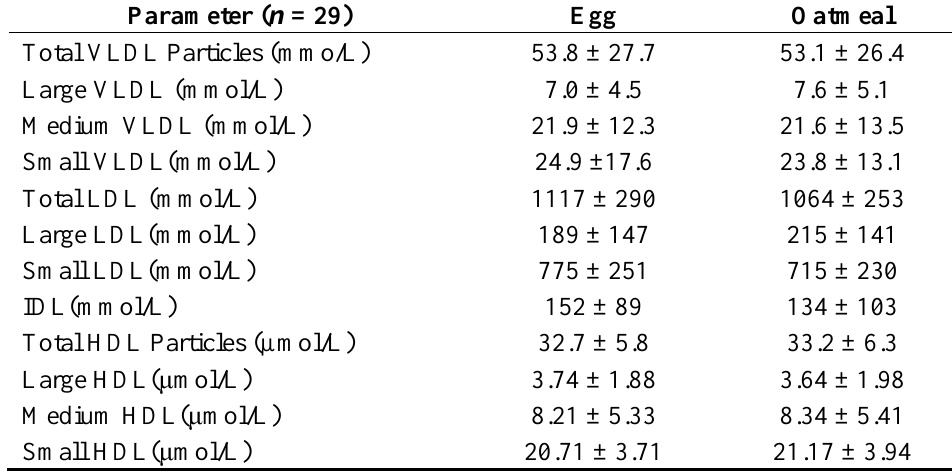
Table 4. Concentrations of VLDL, IDL, LDL, and HDL subclasses after the egg and oatmeal breakfasts